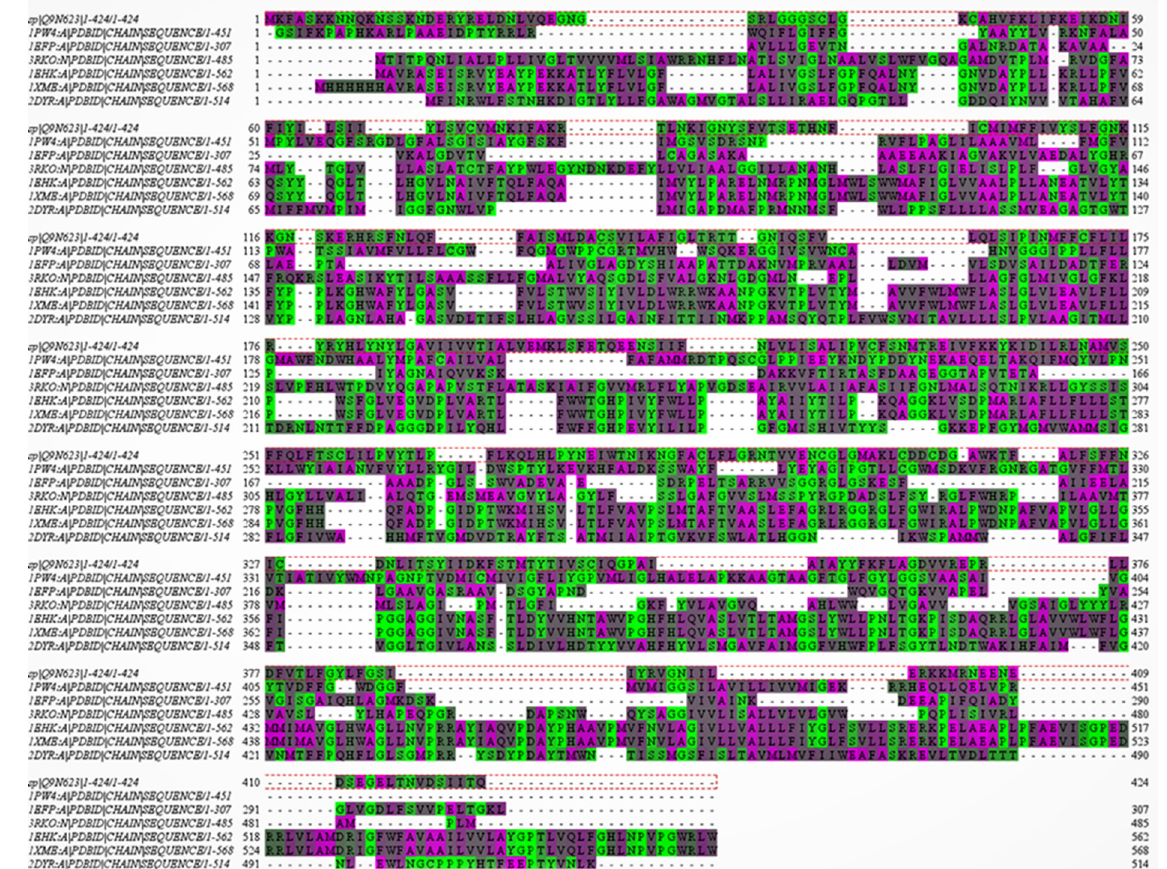
Figure 2. Aligned sequences of PfCRt with various templates.